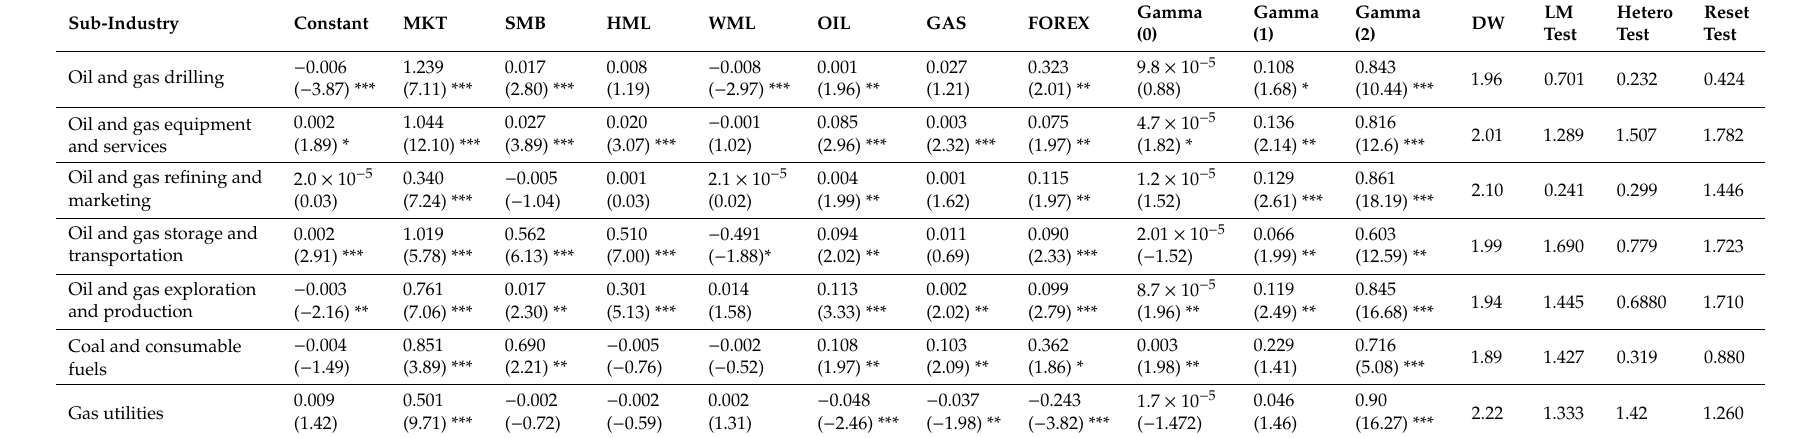
Table 2. Results for